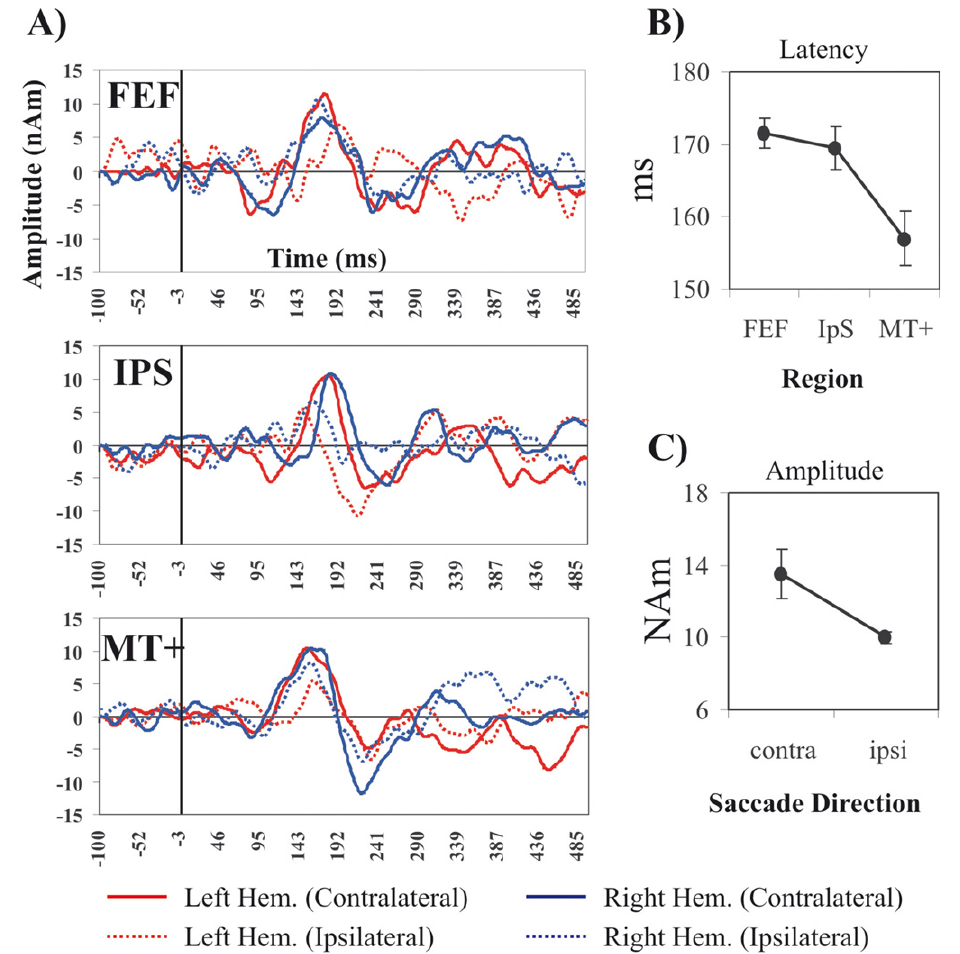
Figure 2. Single SRT interval Analysis of MEG waveforms. (A) Forward grand averages of MEG source waveforms from the three ROIs (FEF, IPS, MT + ). Red and blue lines represent respectively time courses for left and right hemisphere ROIs. Continuous and dashed lines indicate contralateral and ipsilateral target/ saccade direction. The black vertical line indicates the visual stimulus onset. (B) ANOVA for single interval analysis: latency and main effect of ROIs (MT + , IPS, FEF). Vertical bars indicate standard errors of the mean (s.e.m). (C) Amplitude and main effect of Hemisphere (Contralateral,